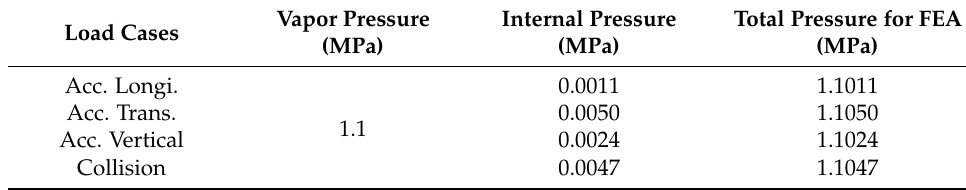
Table 4. Resultant pressure for the load